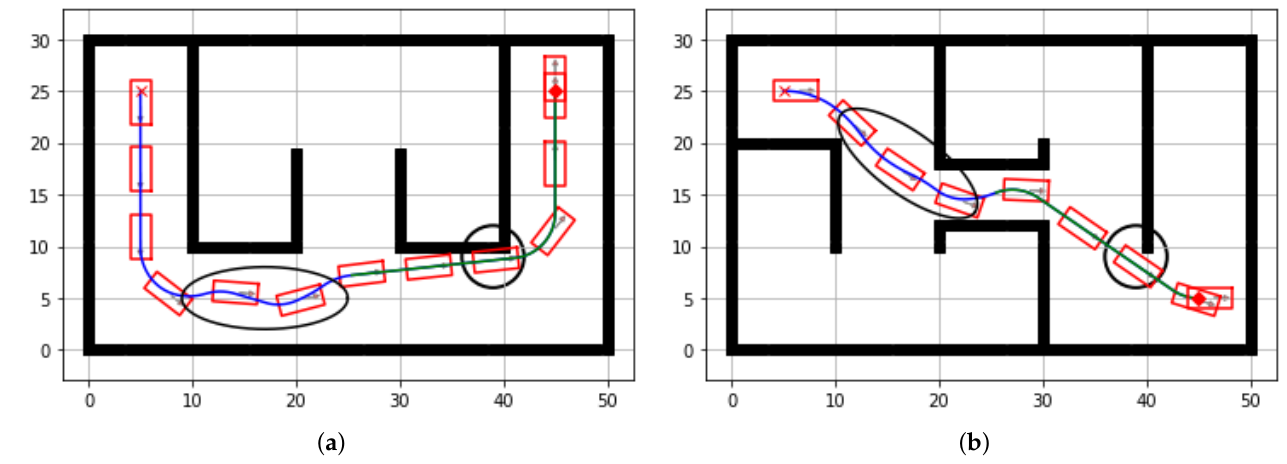
Figure 2. Original Hybrid A-star path planning in simulations. ( a ) Grid map A. ( b ) Grid map